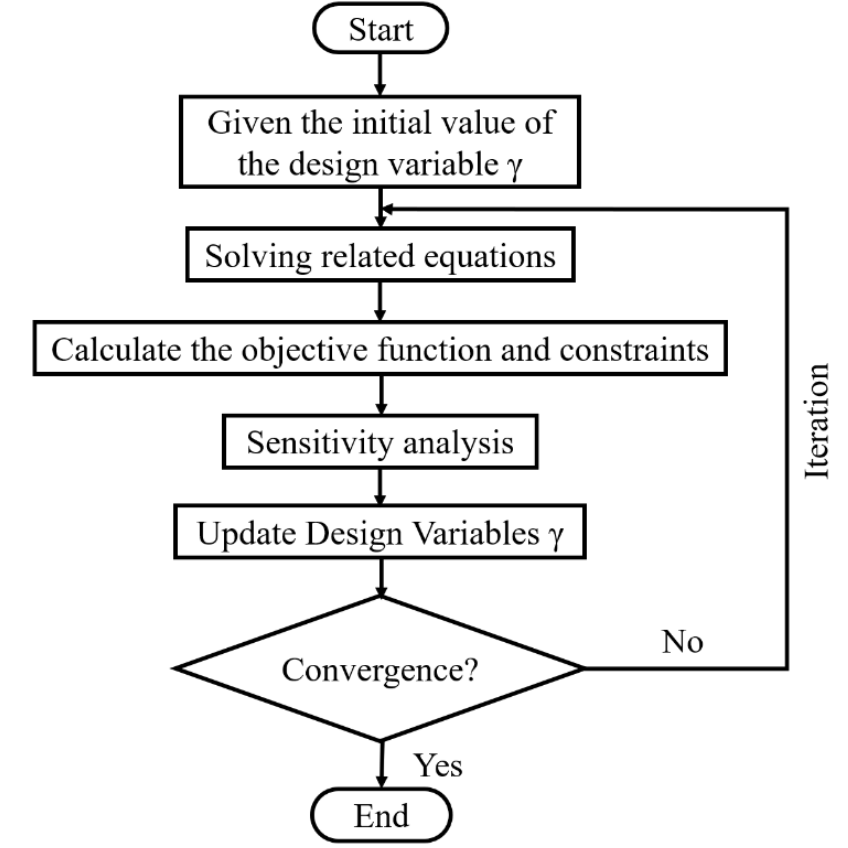
Figure 3. The flow chart of the optimization design.